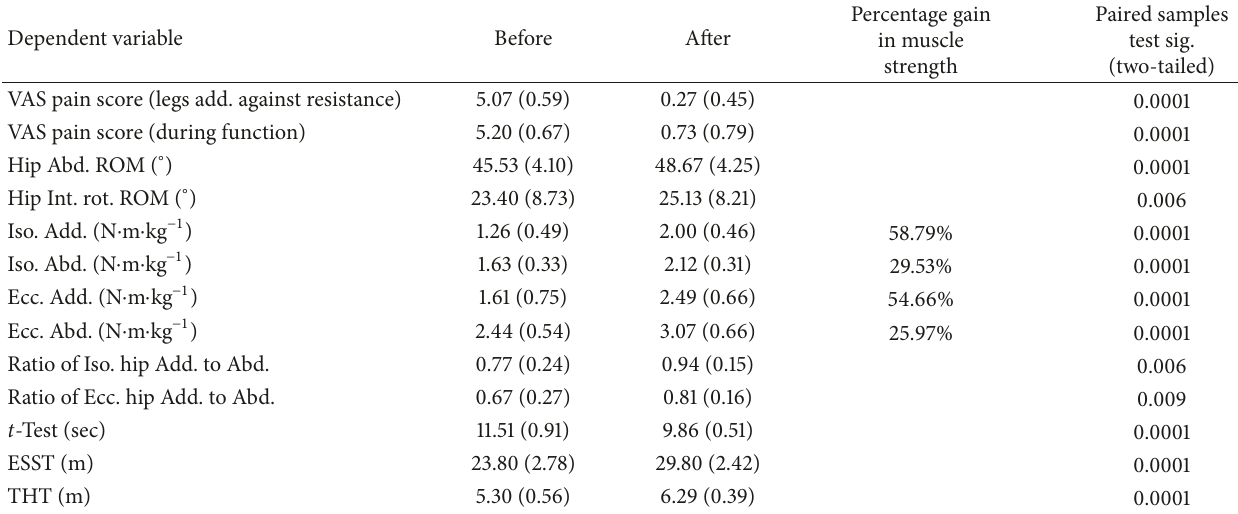
Table 4: Dependent variables, before and after values, and significance level after the paired samples t